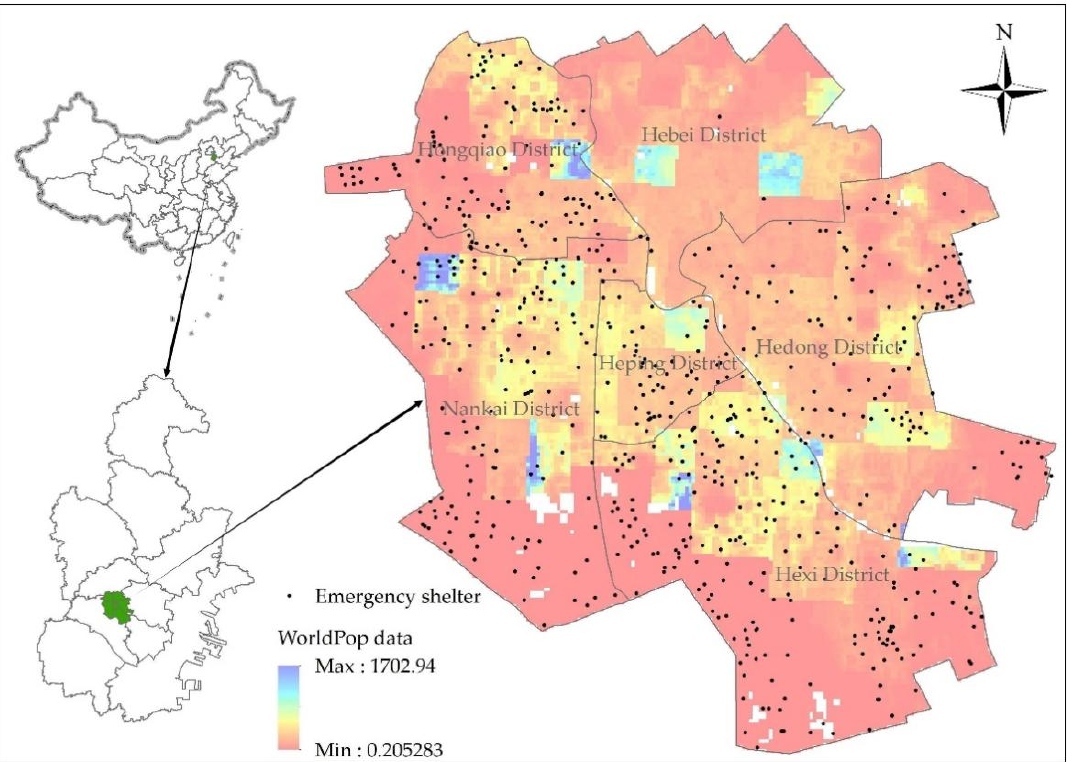
Figure 1. Spatial distribution of population density and emergency shelters in Tianjin urban area, China.